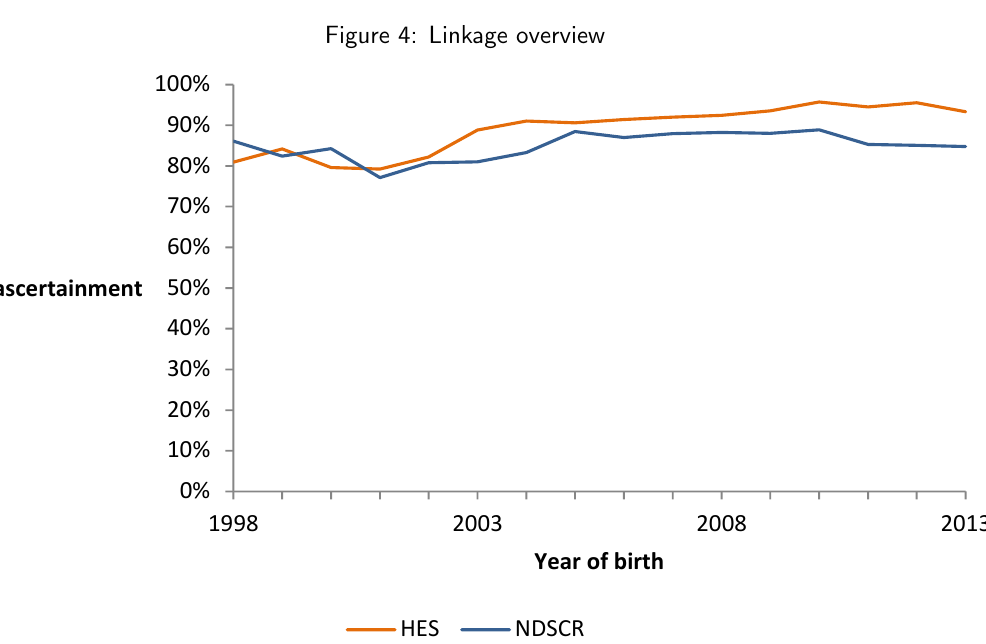
Figure 4: Linkage